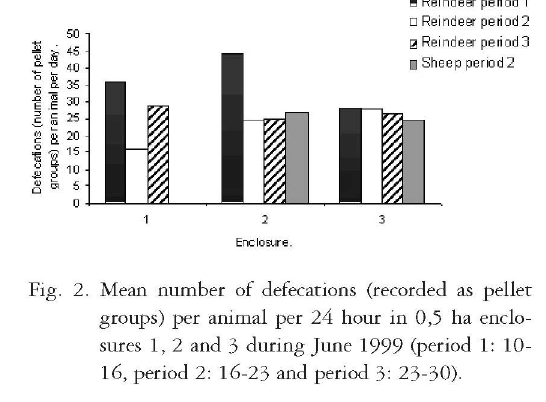
Fig. 2. Mean number of defecations (recorded as pellet groups) per animal per 24 hour in 0,5 ha enclo¬ sures 1, 2 and 3 during June 1999 (period 1: 10¬ 16, period 2: 16-23 and period 3: